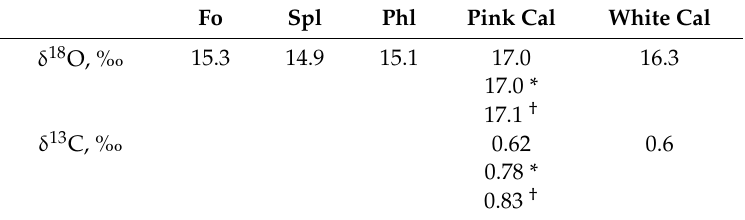
Table 4. Isotopic composition of forsterite, spinel, phlogopite, and calcite in the Parker mine suite. Fo Spl Phl Pink Cal White Cal δ 18 O, % (cid:24) 15.3 14.9 15.1 17.0 16.3 17.0 * 17.1 † δ 13 C, % (cid:24) 0.62 0.6 0.78 * 0.83